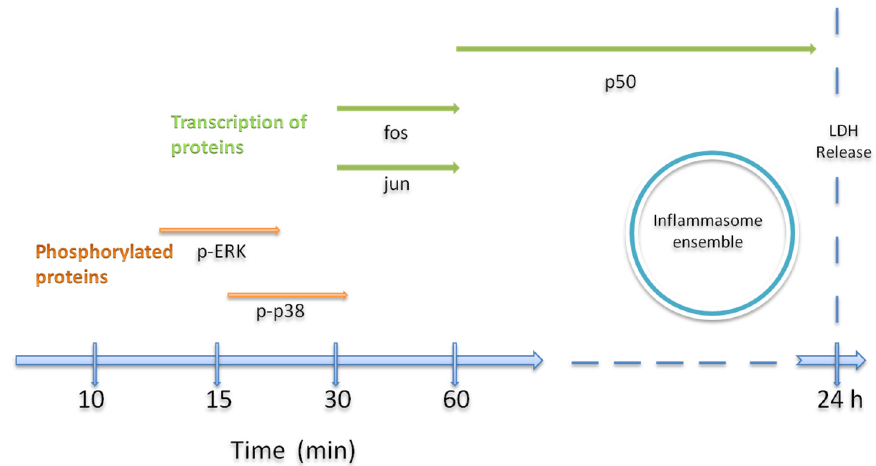
Figure 9. Proposed time lapse of activated MAPKs and their transcriptional activators. Phosphorylated MAPK proteins and activated transcripts of AP-1 (Fos, Jun) and NF- κ B elicited by treatments with the monomeric VCC on THP-1-treated cells.